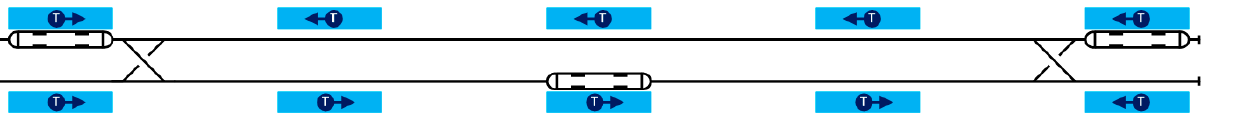
Figure 4. Examples of tram route terminals without applying tram loops: ( A ) Alexanderplatz, Berlin, Germany; ( B ) Rogier, Brussels, Belgium; ( C ) Kanta, Olsztyn, Poland (own study). In case there is no space for placing two tracks and a terminus at the switch-back terminal, it is possible to place a single track intended only for turning around and locate the tram stops before the switch-back terminal. An example of such an application is shown in Figure 5. Figure 5. Terminating a tram route without applying a tram loop—Warsaw Street, Berlin, Germany: ( A ) own study based on openstreetmap.org; ( B ) own study. 5.2.2. Possibility of Commissioning Subsequent Sections of a Constructed Tram Route Construction of a new tram route or extension of an existing one is cost-intensive and time-consuming. Commissioning such an investment may take place up to several years after commencing it.